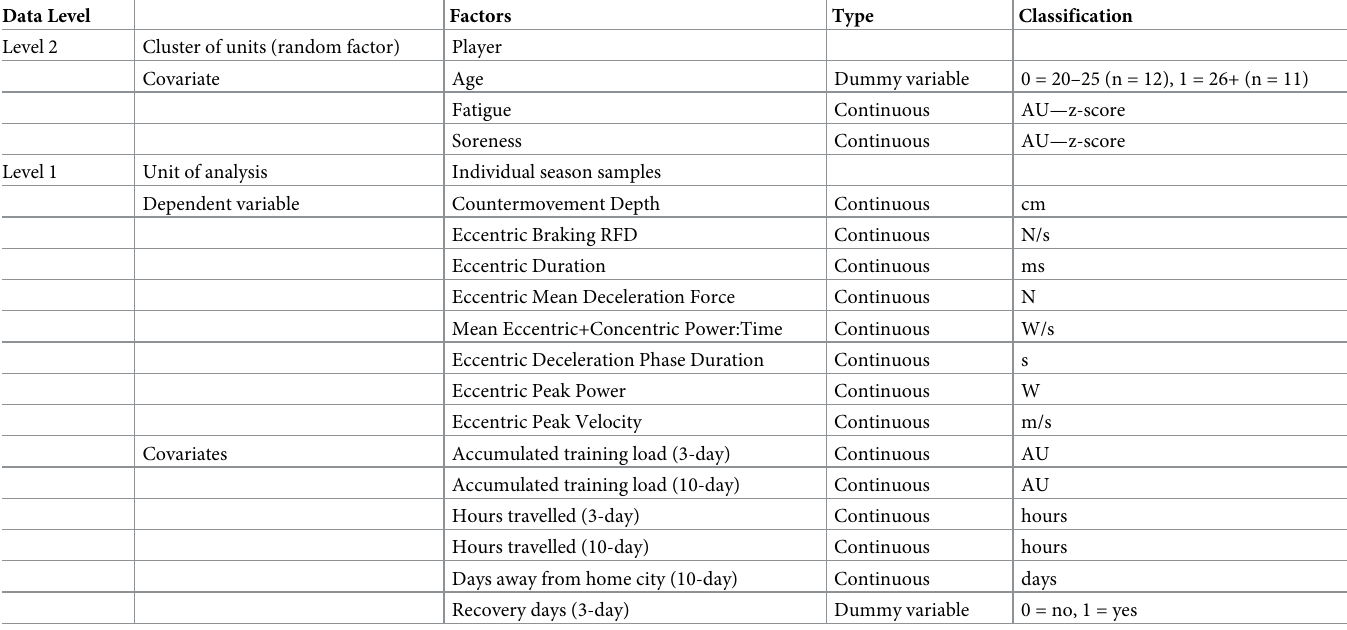
Table 2. Covariates included in model specification for countermovement jump